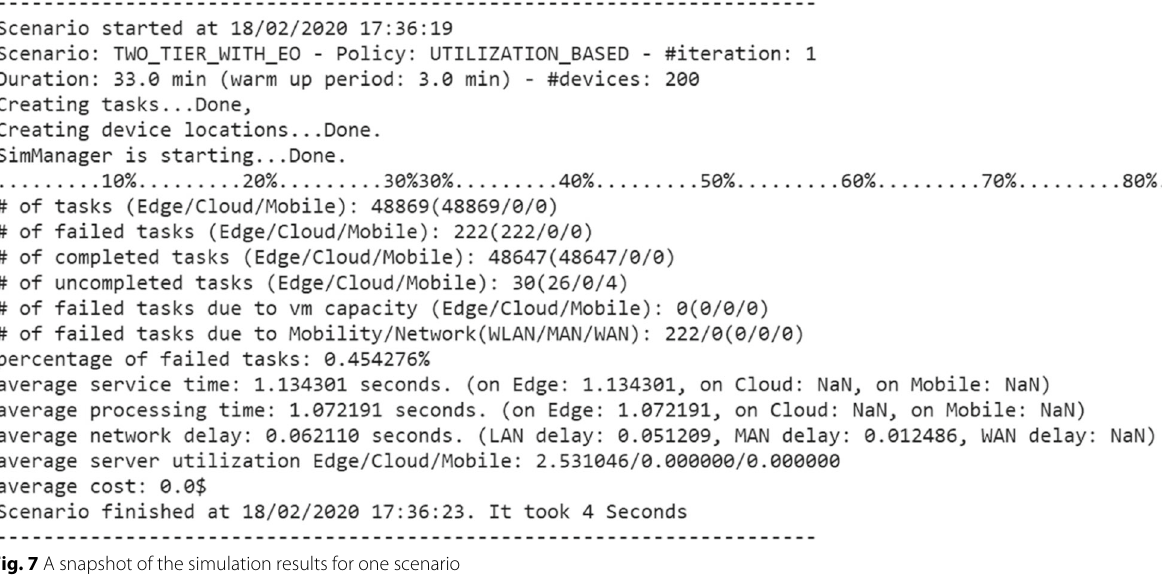
Fig. 7 A snapshot of the simulation results for one